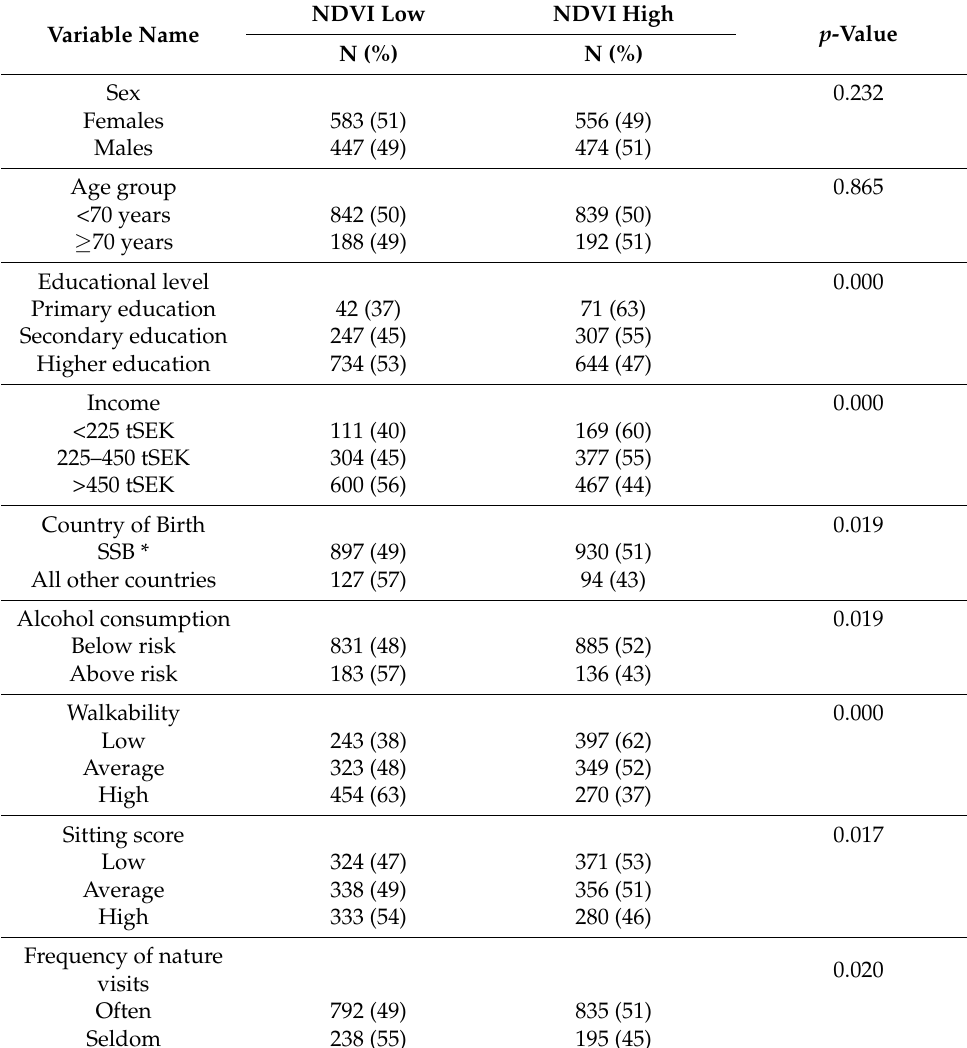
Table 1. Background characteristics related to normalized difference vegetation index (NDVI) values in 50 m buffers below and resp. above the median levels (NDVI =